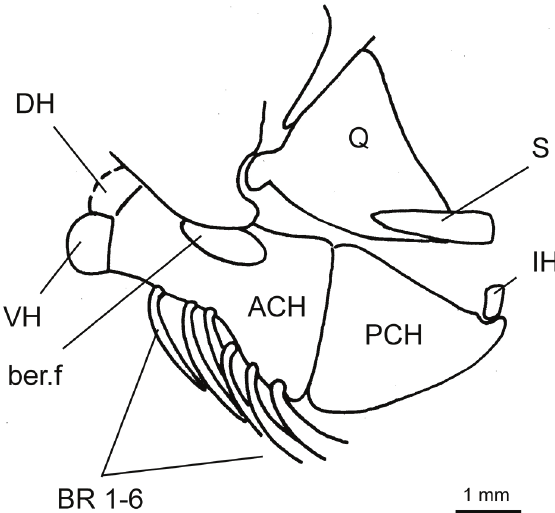
Figure 6 . † Scutatuspinosus itapagipensis Santos and Corrêa 1985: hyoidean bones and associated structures of DGM 1262-